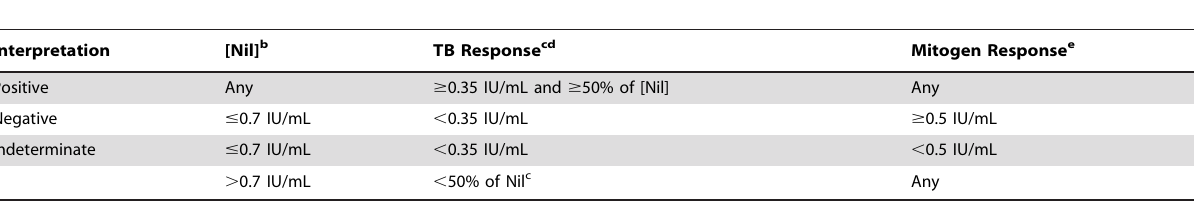
Table 1. Interpretation Criteria used for QuantiFERON-TB Gold and QuantiFERON-TB Gold In-Tube a Tests.